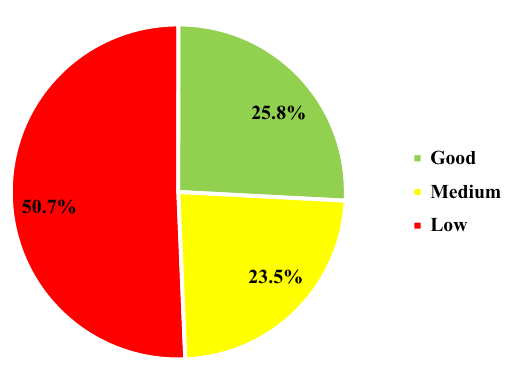
Fig. 9 Assessment of